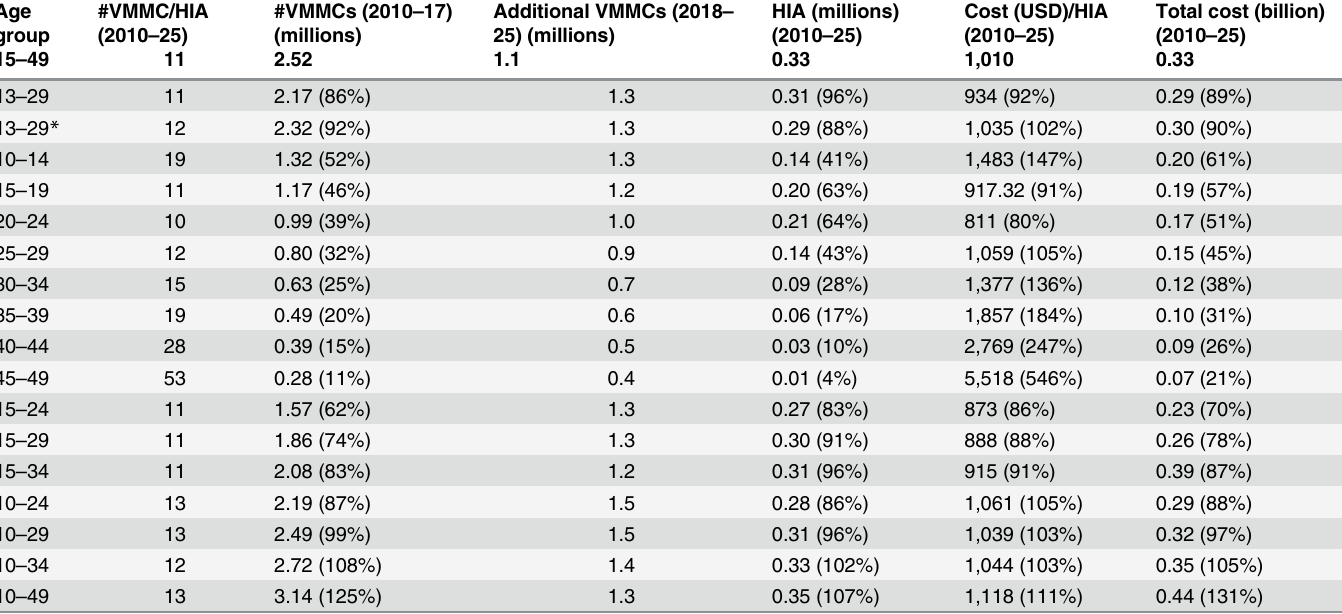
Table 2. Epidemic impact of prioritizing different age-group bands and brackets through the voluntary medical male circumcision (VMMC)